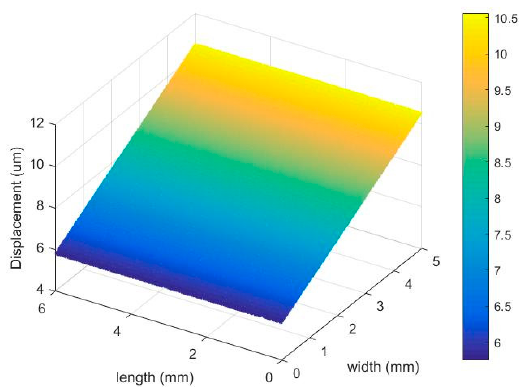
Figure 15. The overall displacement diagram of the measured object.